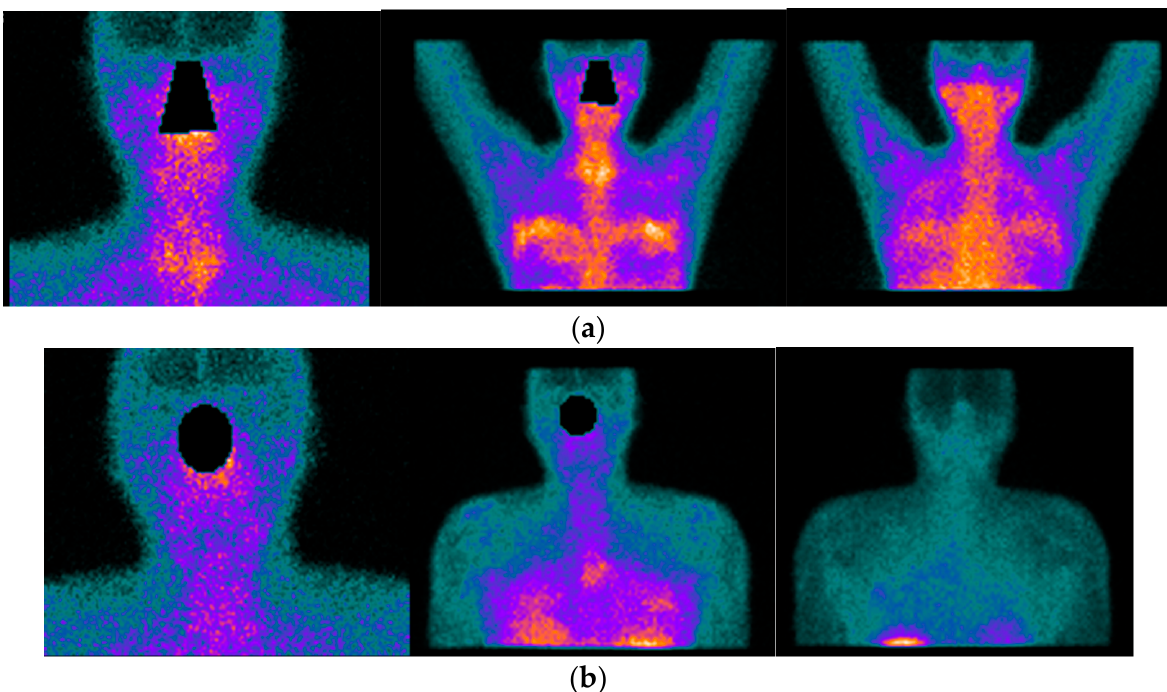
Figure 4. 42-year-old female patient with the previous history of bilateral mammoplasty; four years later she complained of dryness (VAS 5/10), fatigue (VAS 10/10), pain (VAS:8/10) ESSPRI: 23, and thyroiditis. She was diagnosed with SS under ACR-EULAR criteria and she started treatment with DMARDS for two years without relieving symptoms. She asked her surgeon to remove the implants and six months after the removal of the implants there was an improvement in her clinical condition, dryness (VAS: 2/10), fatigue (VAS:6/10), pain (VAS: 5/10) post-surgery ESSPRI: 13. In ( a ) 99m Tc HYNIC-TOC images show high abnormal uptake of the radiotracer in the thyroid gland, subman- dibular glands, with a high abnormal bilateral mammary periprosthetic distribution of the radio- tracer. SS was diagnosed under ACR-EULAR criteria. In ( b ) 99m Tc HYNIC-TOC images 6 months post removal of prosthesis show a significant decrease in uptake of the radiotracer in submandibular glands and thyroid gland. There was a concern that silicone could be associated with SS.